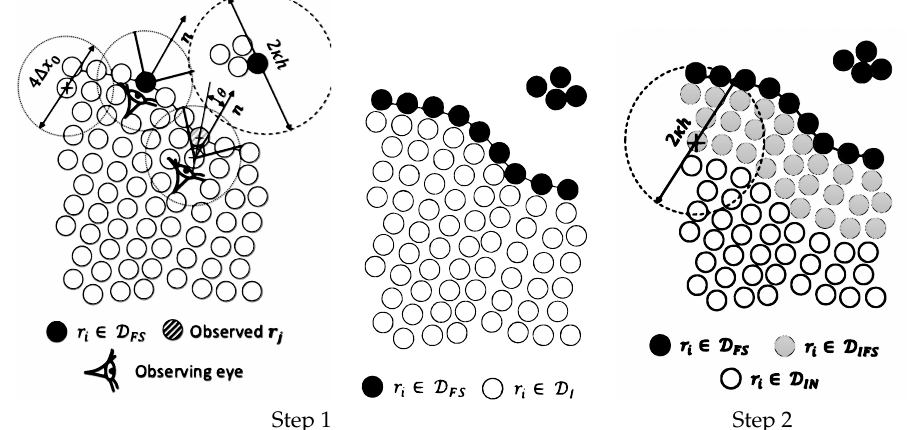
Figure 2. Principals of the free surface particles detection, Step 1 presents the free surface particles detection conditions and Step 3 presents the definition of inner particles near to the free surface